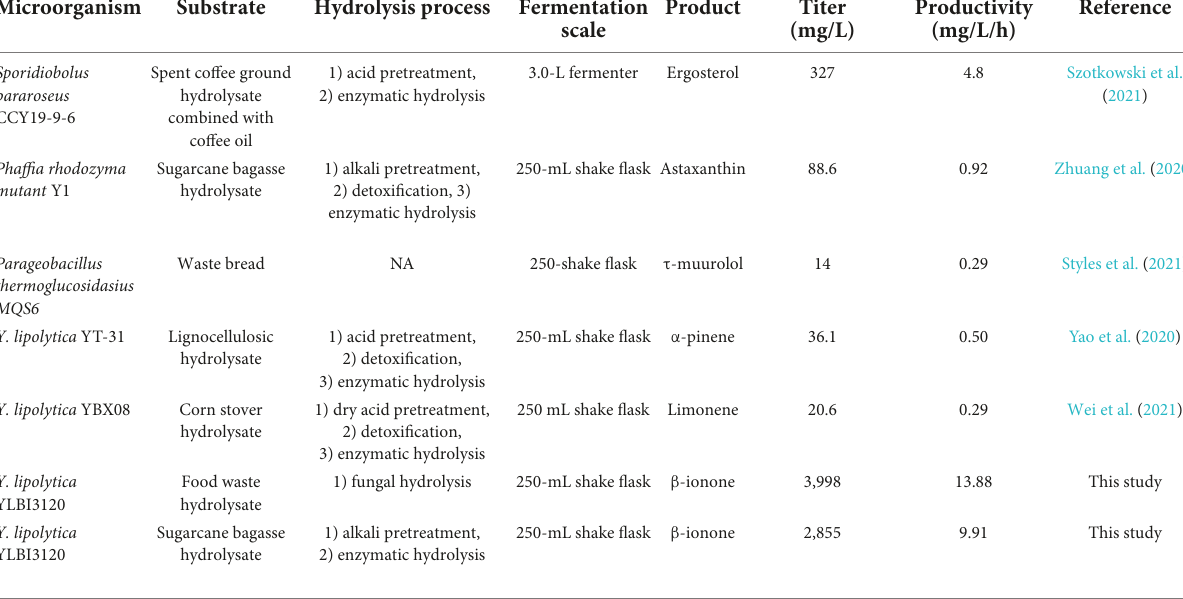
TABLE 3 Overview of terpenoid flavor and fragrance compounds production from low-cost feedstocks by microbial cells.